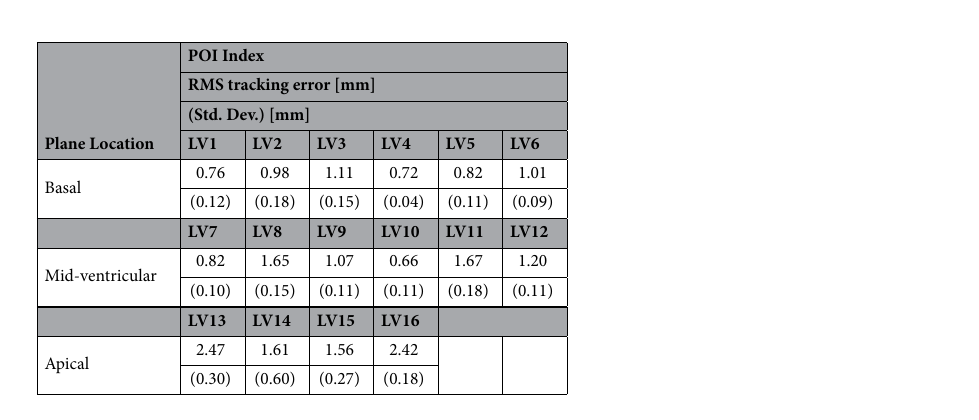
Table 1. RMS tracking errors of the numerical phantom for the 16-point LV model for the LV epicardium.